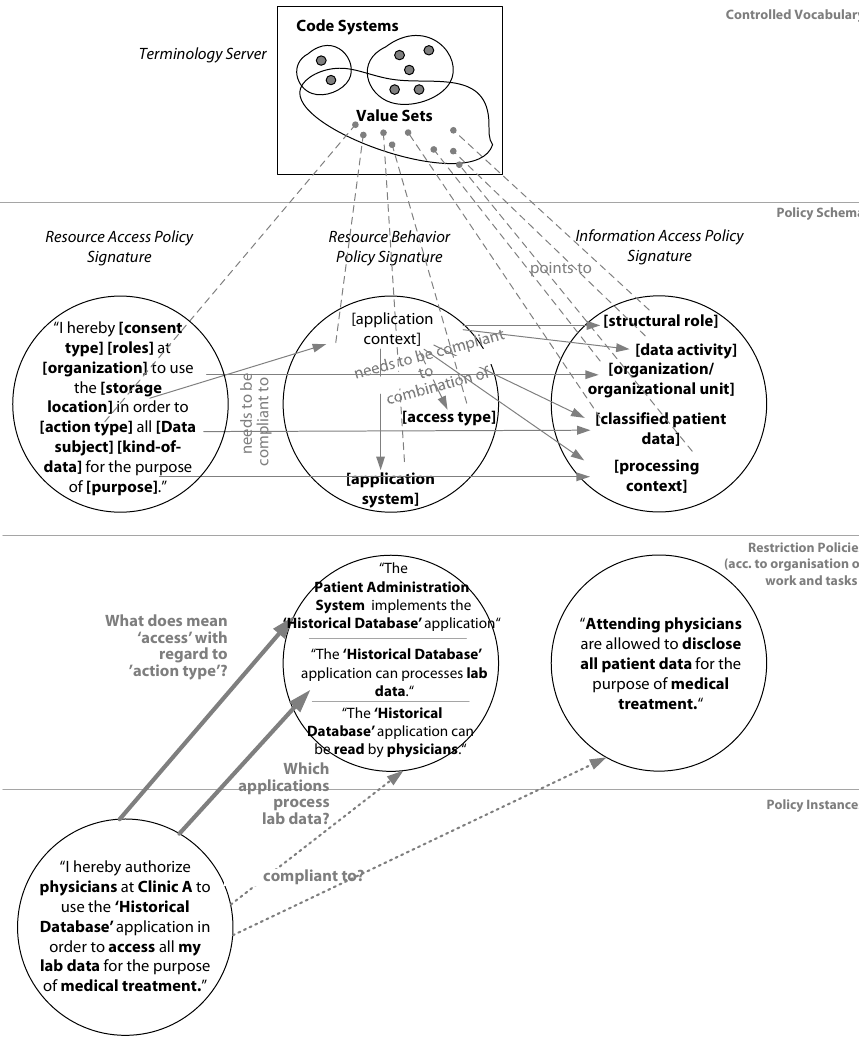
Figure 2. Policy relationships on the basis of a terminology